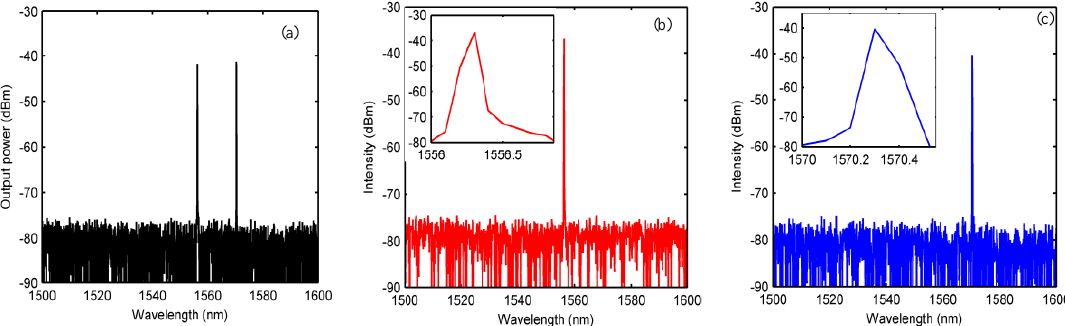
Figure 7. Test spectra of lasers in single-wavelength and dual-wavelength output states: ( a ) 1556-nm and 1570-nm output, ( b ) 1556-nm output, and ( c ) 1570-nm output.